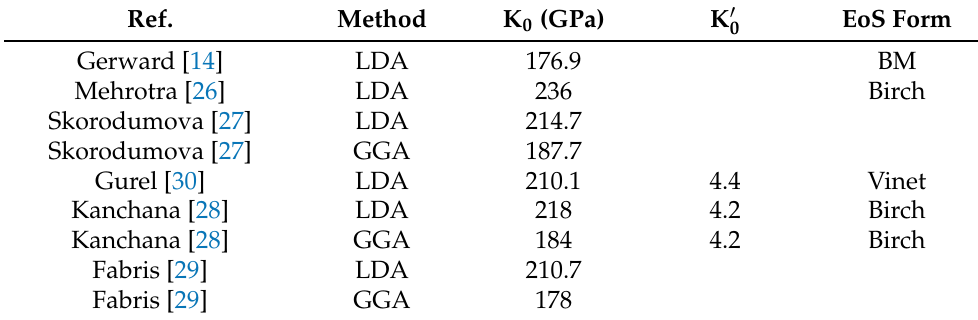
Table 2. Bulk moduli of Fm ¯3 m cerium dioxide as determined by